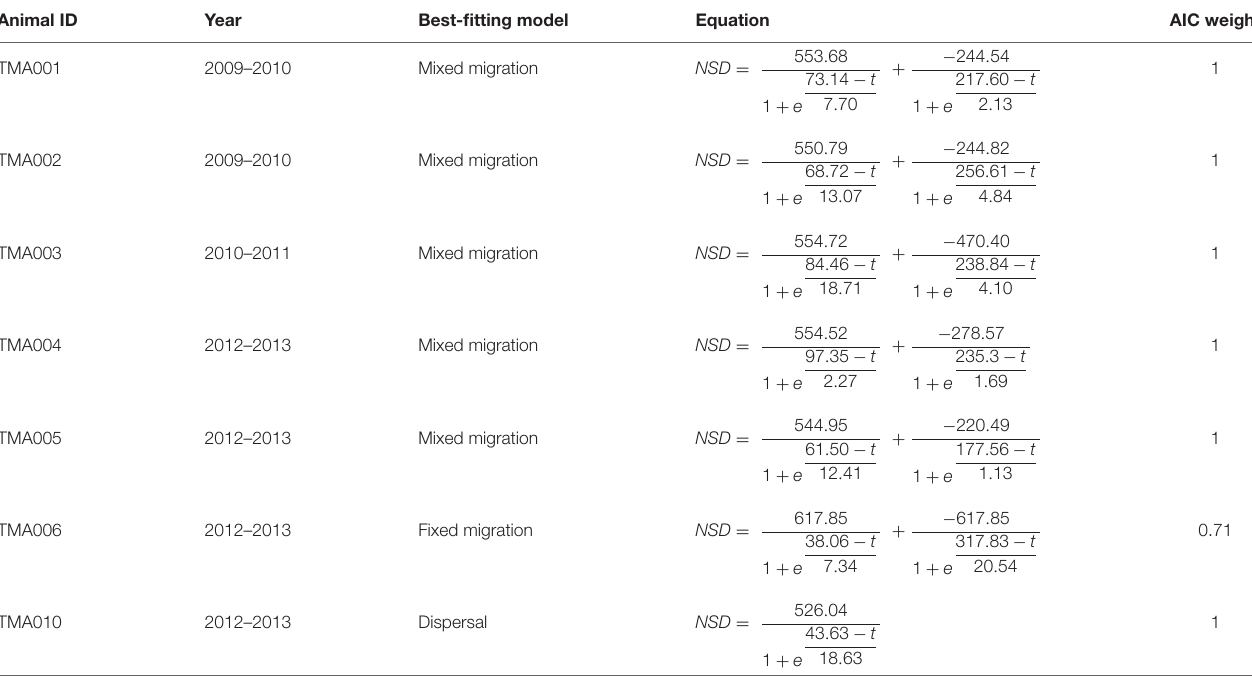
Animal ID Best-fitting